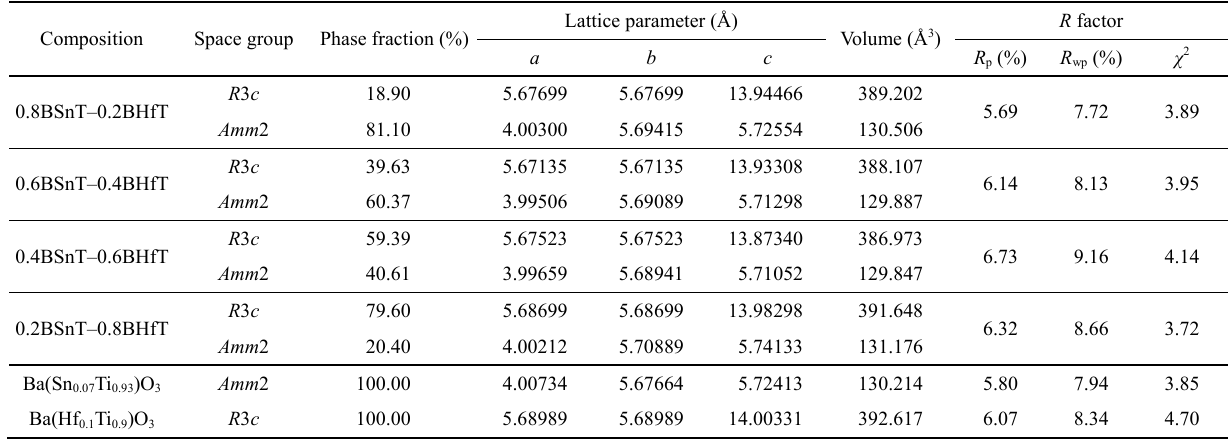
Table 1 Lattice parameters fitted by the Rietveld refinement for x Ba(Sn 0.07 Ti 0.93 )O 3 –(1 − x )Ba(Hf 0.1 Ti 0.9 )O 3 ceramics based on the room-temperature XRD data from Fig.